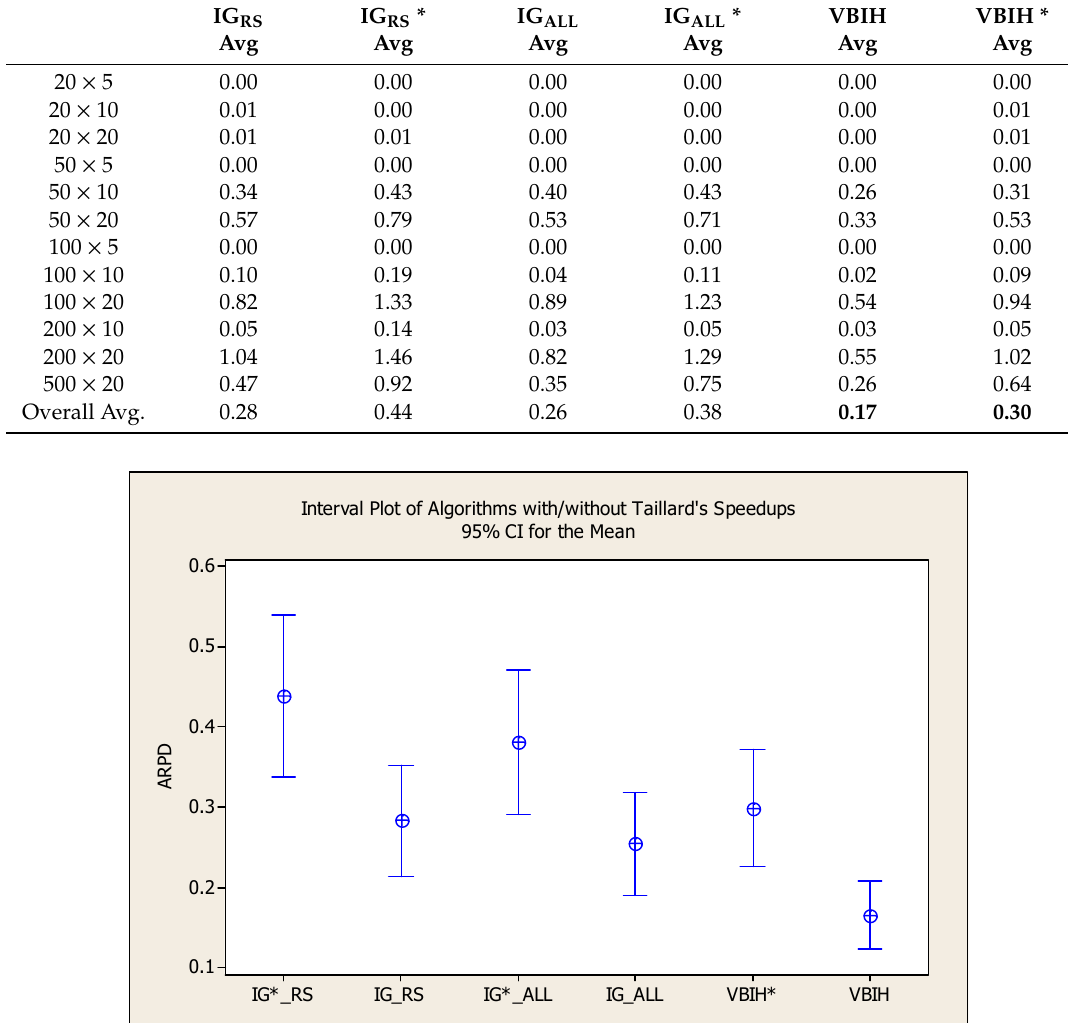
Table 9. Computational results of Taillard’s instances with T max = 45 × n × m milliseconds (The bolds show better results).